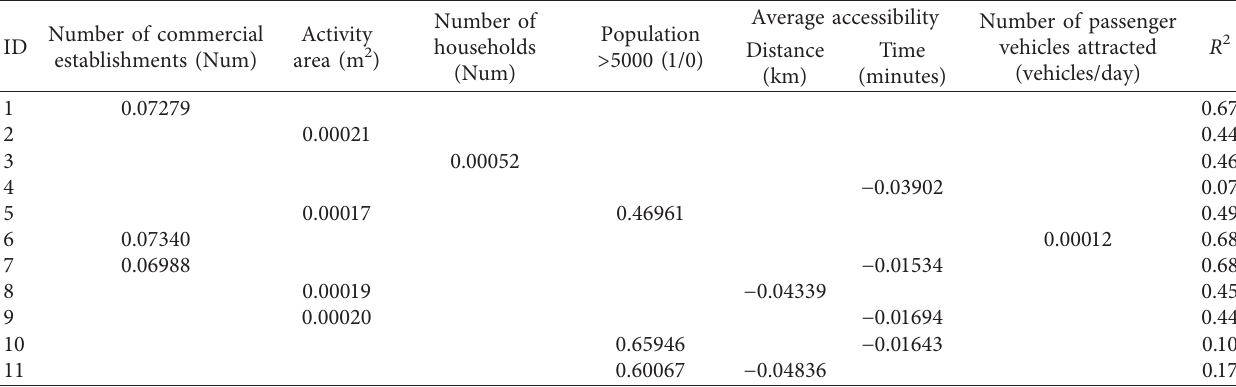
Table 7: Values of calibrated parameters for equation (3): model specifications with direct variables.